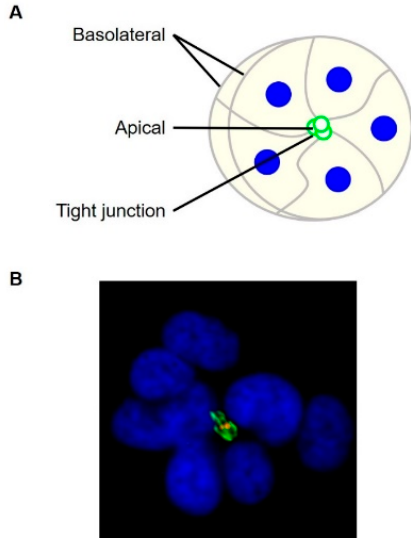
Figure 1. Huh-7.5 cells cultured in Matrigel. ( A ) Diagrammatic of a polarized Huh-7.5 organoid with membrane domains. ( B ) Huh-7.5 cells were grown in Matrigel, infected with DiD-labelled HCV (red) for 90 min, and probed for tight junctional marker ZO-1 (green).